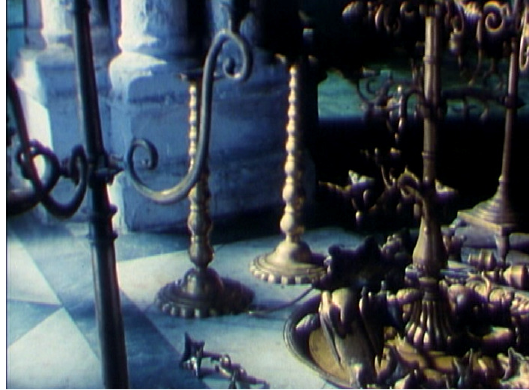
Figure 16. Puja utensils used by Satyajit Ray, screen grab, Utsab